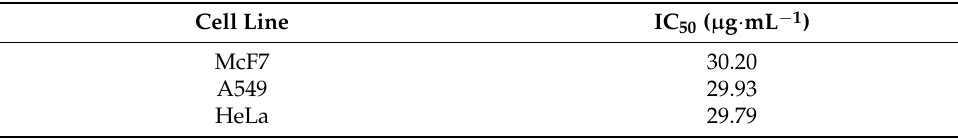
Figure 5. Cell viability results obtained from the cell viability assay (CCK-8) upon incubation of A549, HeLa, and MCF7 cells. ( a ) Cell viability of unloaded nanogels (NGs) tested for A549, McF7, and HeLa cells after 72 h of treatment. ( b) Cell viability of cytochrome C-loaded nanogels (NG@CC) with a protein loading content of 9% and free cytochrome C (CC) tested on McF7 cells after 72 h of treatment. ( c ) Cell viability of cytochrome C-loaded nanogels (NG@CC) with a protein loading content of 9% and free cytochrome C (CC) tested on A549 cells after 72 h of treatment. ( d ) Cell viability of cytochrome C-loaded nanogels (NG@CC) with a protein loading content of 9% and free cytochrome C (CC) tested on HeLa cells after 72 h of treatment. The cell viability was normalized to 100% using the nontreated control. Measurements were performed in triplicates and repeated three times. Data are represented as the mean of the three independent experiments with standard deviation. Table 3. Calculated IC 50 values for CC@NGs.